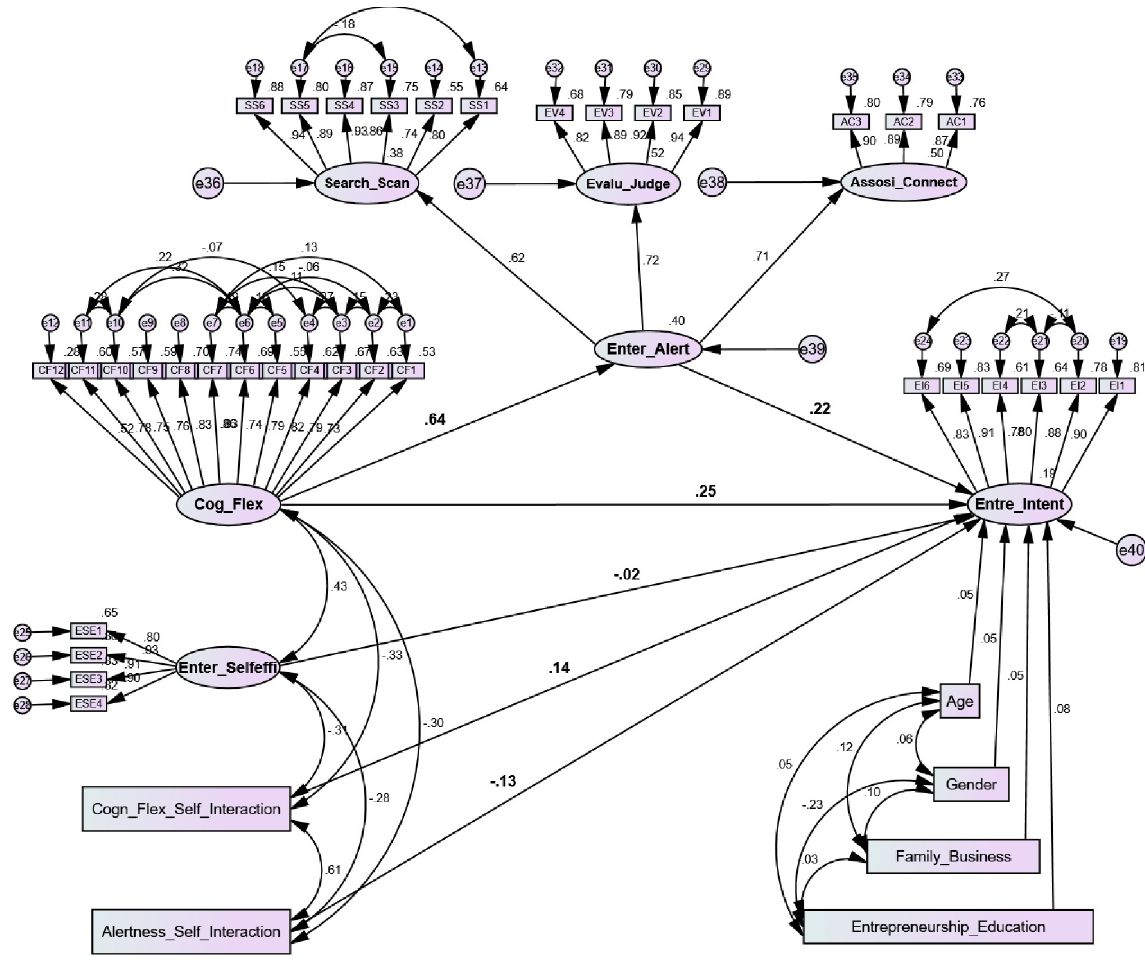
Fig 4. Structural